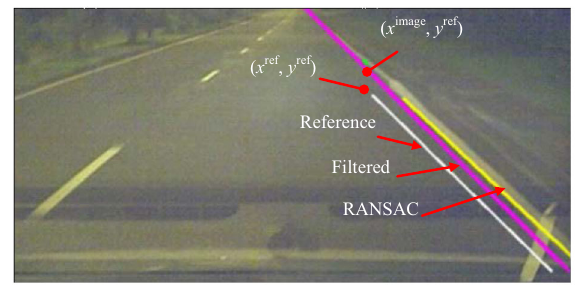
Fig. 7 Lines used in the